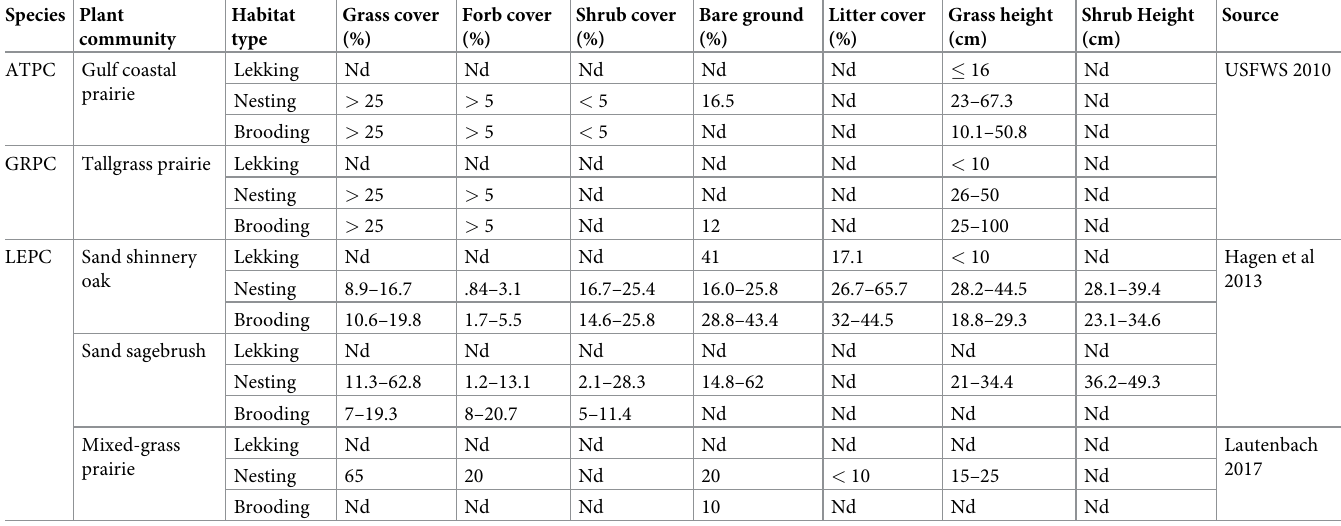
Table 1. Prairie-chicken habitat requirements. Species Plant community